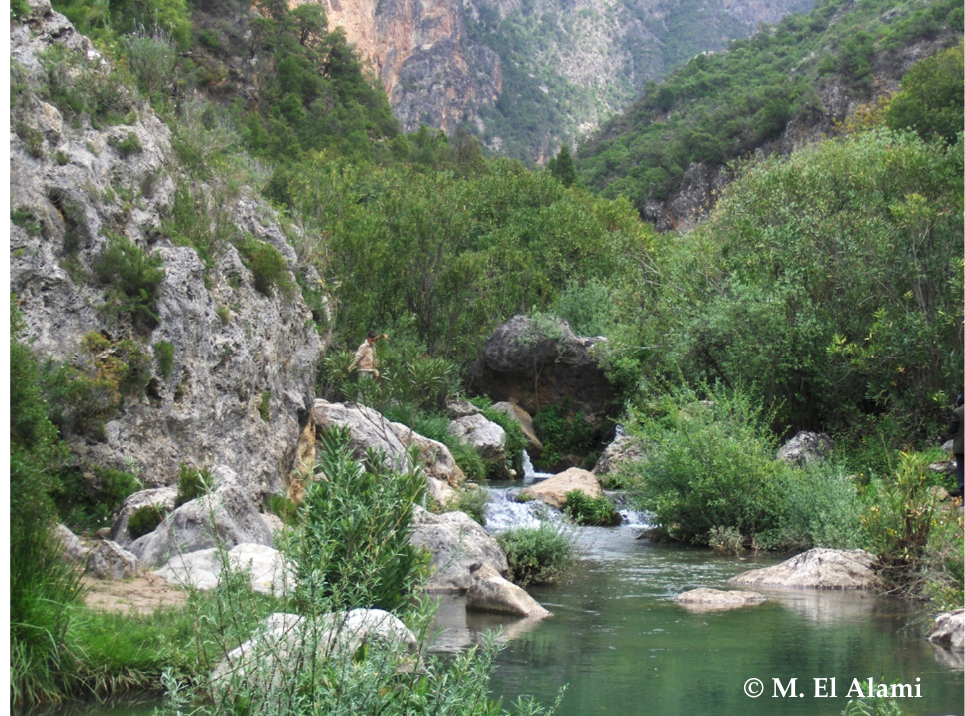
Figure 3. Oued Kelaa a typical habitat of Alainites sp1.